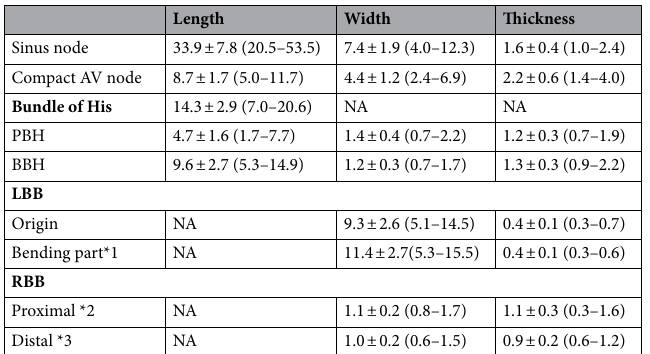
Table 1. Dimensions of the CCS components. Values are mean ± SD (range) in mm. * 1 Distal of common faacicle of the LBB coursing bendingly at the left interventricular crest. * 2 Origin part of the RBB from the end of the BBH. * 3 Just caudal point of bending and transitional part of the RBB which the ascending RBB bends and then